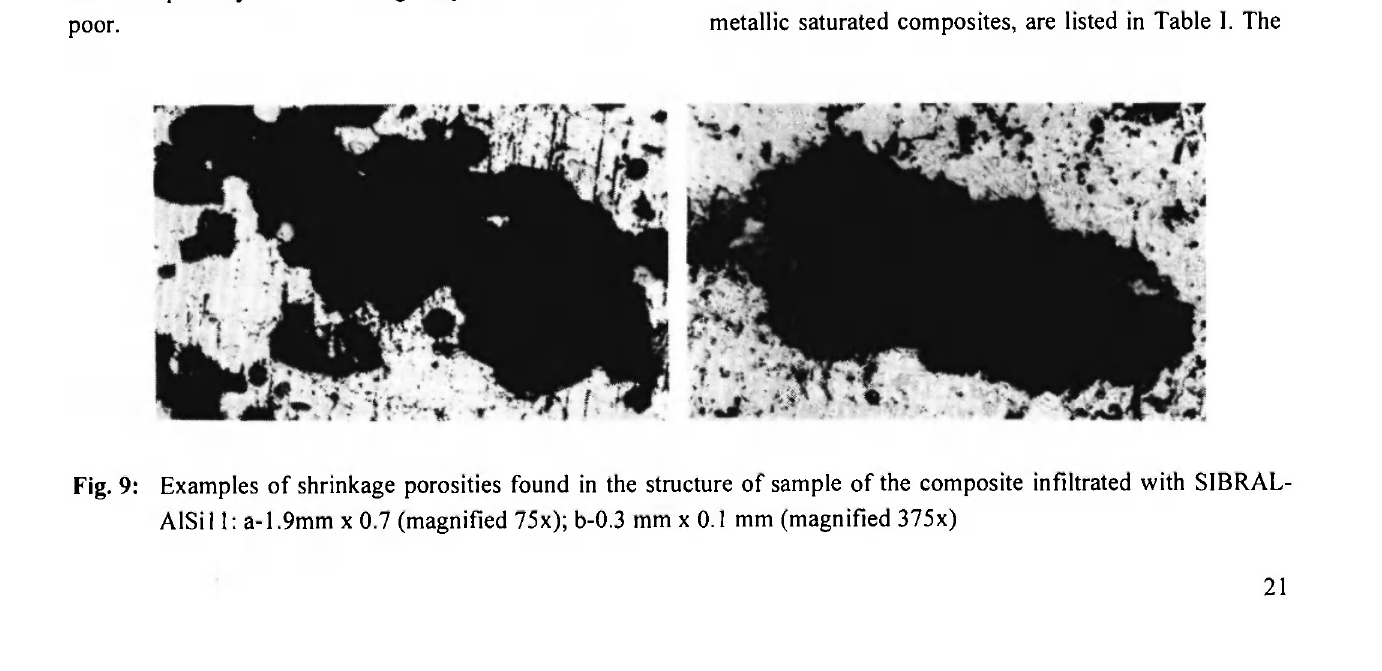
Fig. 8: A gas bubble observed in the structure of the composite structure infiltrated with SIBRAL- AlSill. Magnified 375x